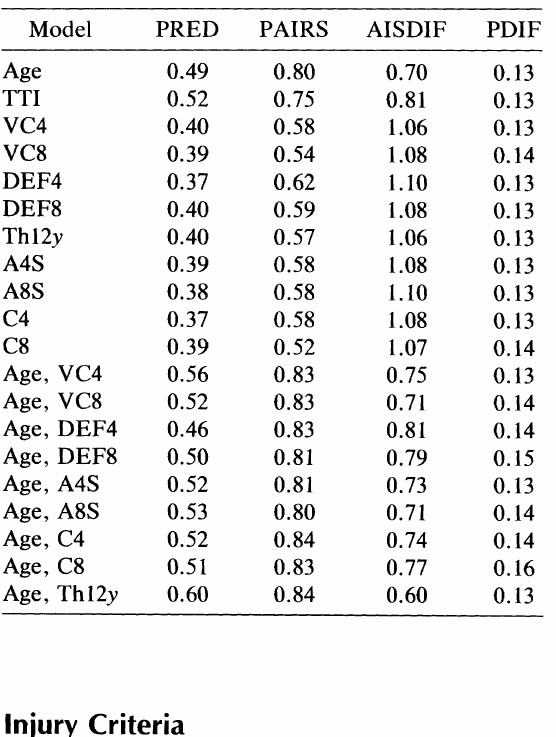
Table 1. Probability Analysis of Thoracic Injury Severity According to Four Chosen Goodness of Fit Criteria: TOAIS 0-5